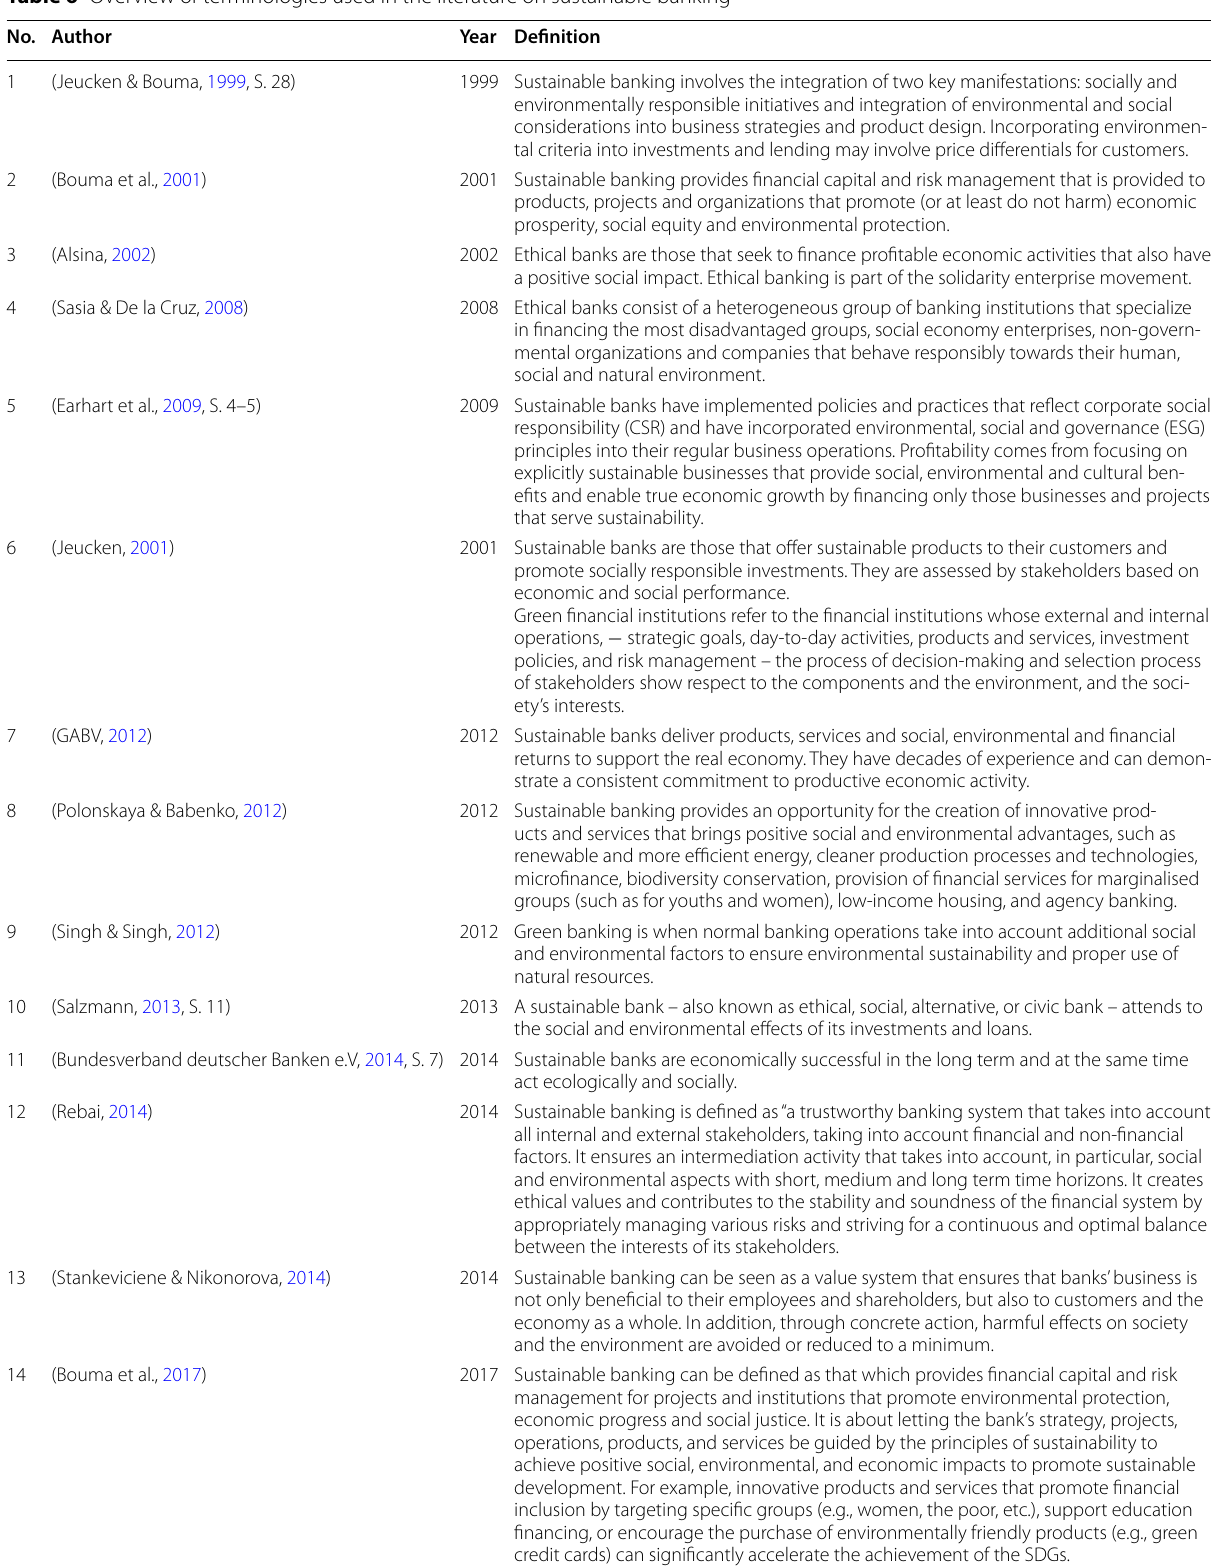
Table 6 Overview of terminologies used in the literature on sustainable banking No.